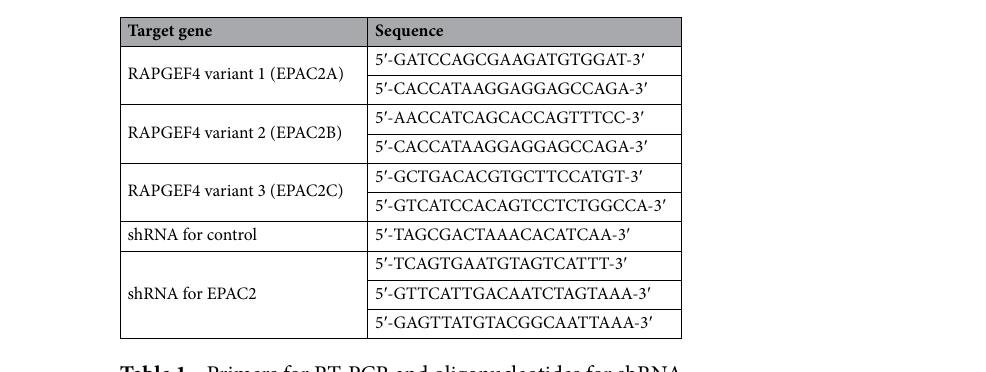
Table 1. Primers for RT-PCR and oligonucleotides for